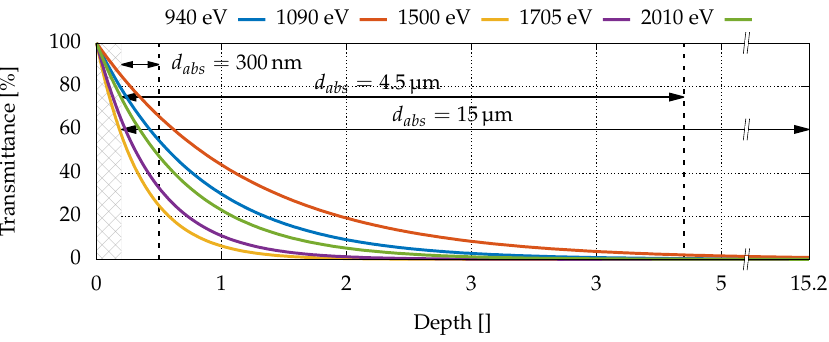
Figure 3. Transmittance as a function of the absorption layer width at different radiation energies. The 200 nm p-GaAs layer is grayed out. The 200 nm p-GaAs layer is grayed